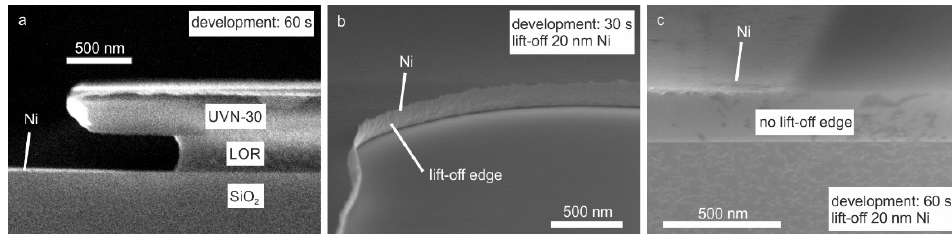
Figure 1. ( a , b ) Fabrication process of graphene/grid substrates: the lithographic step defines an undercut on the photoresist, the deposition of the nickel, followed by the lift off process defines the grid, then the graphene layer previously transferred on PMMA layer is deposited on the grid creating the electrode final electrode. ( c ) Direct solar cells on graphene grids; ( d ) Inverted solar cells on graphene grids; ( e ) Final layout of a BHJ-SCs PTB7-based on graphene/grid substrate (front and back view).